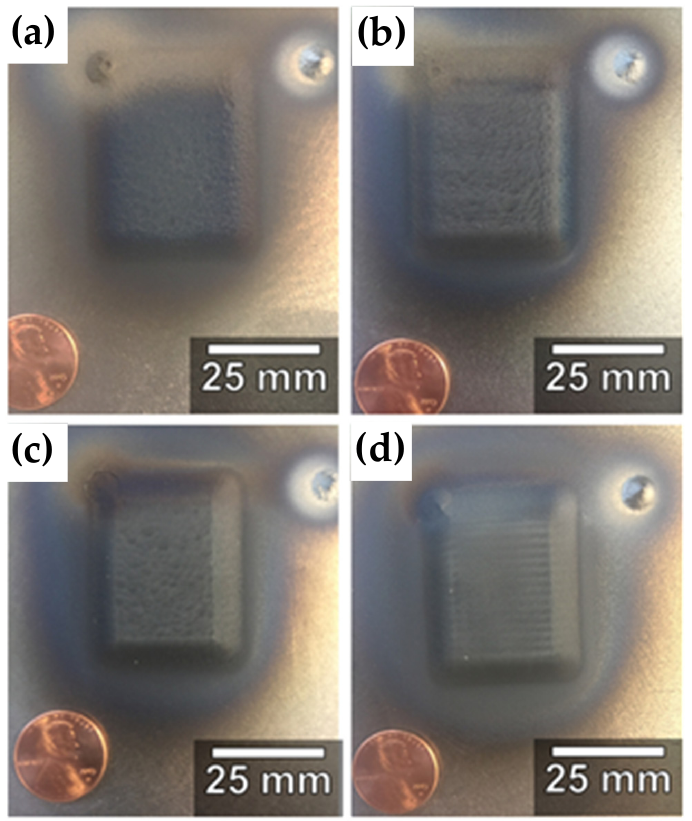
Figure 16. Photographs of ( a ) CS (no laser) and LACS deposits at surface temperatures of ( b ) 500 °C, ( c ) 738 °C, and ( d ) 950 °C. A copper penny is placed next to the deposit for size reference [94].